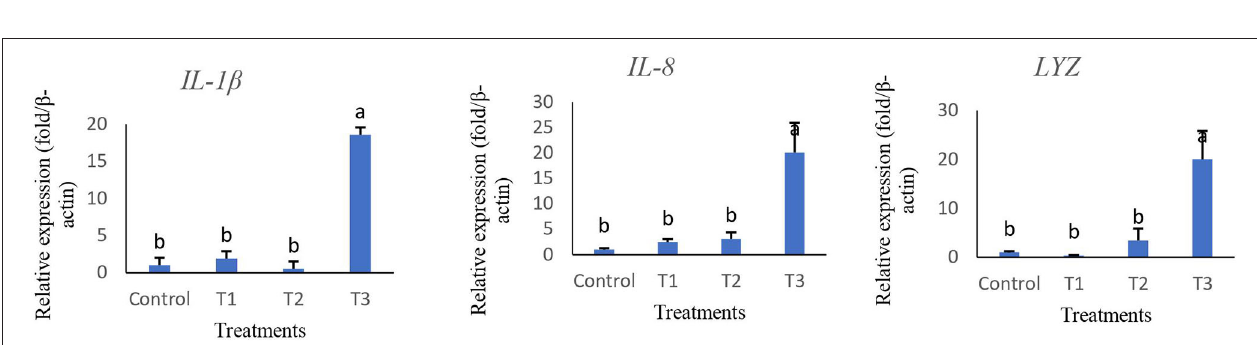
FIGURE 2 | Relative expression of key immune genes of interleukin 1- β ( IL-1 β ), interleukin 8 ( IL-8 ), and lysozyme ( Lys ) in intestine tissue of rainbow trout fed diets incorporated with different levels of zero (Control), 0.5% (T1), 1% (T2) and 2% (T3) of a mixture of herbs ( Mentha longifolia , Thymus carmanicus , Trachyspermum copticum ) for 45 days. Data represent mean ± SE. Bars with different letters indicate significant differences ( P <